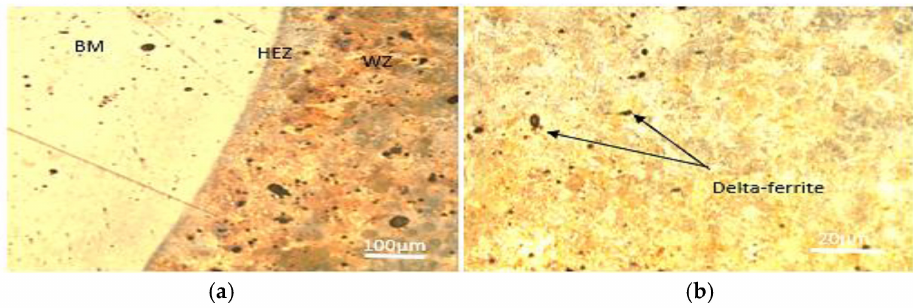
Figure 15. Microstructure of welded joint made of SS316 (sample 1): ( a ) welded joint; ( b ) weld